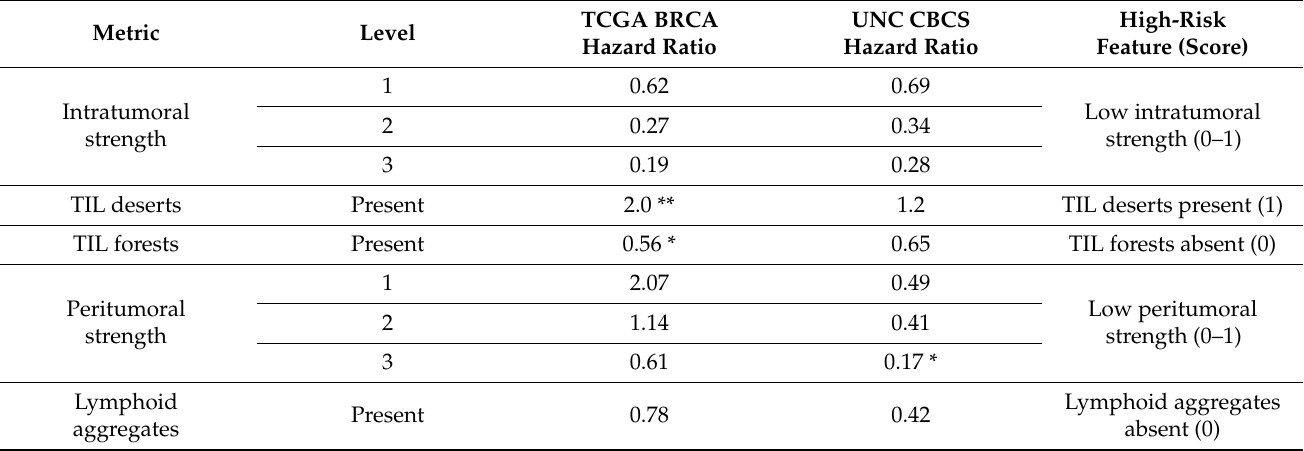
Table 4. Univariate hazard ratios for spatial